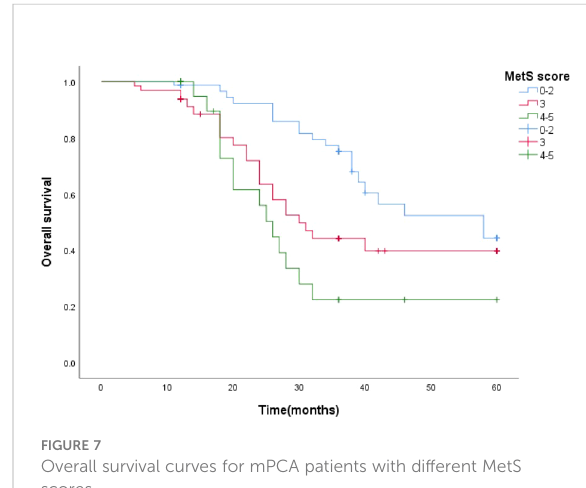
FIGURE 7 Overall survival curves for mPCA patients with different MetS scores.